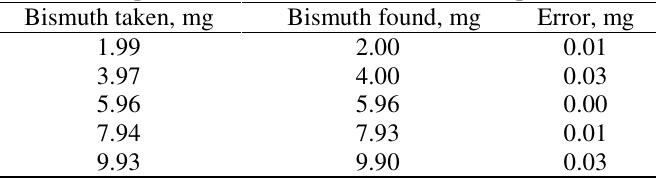
Table 1. Amperometric determination of bismuth (pH 3.0 – 6.0)